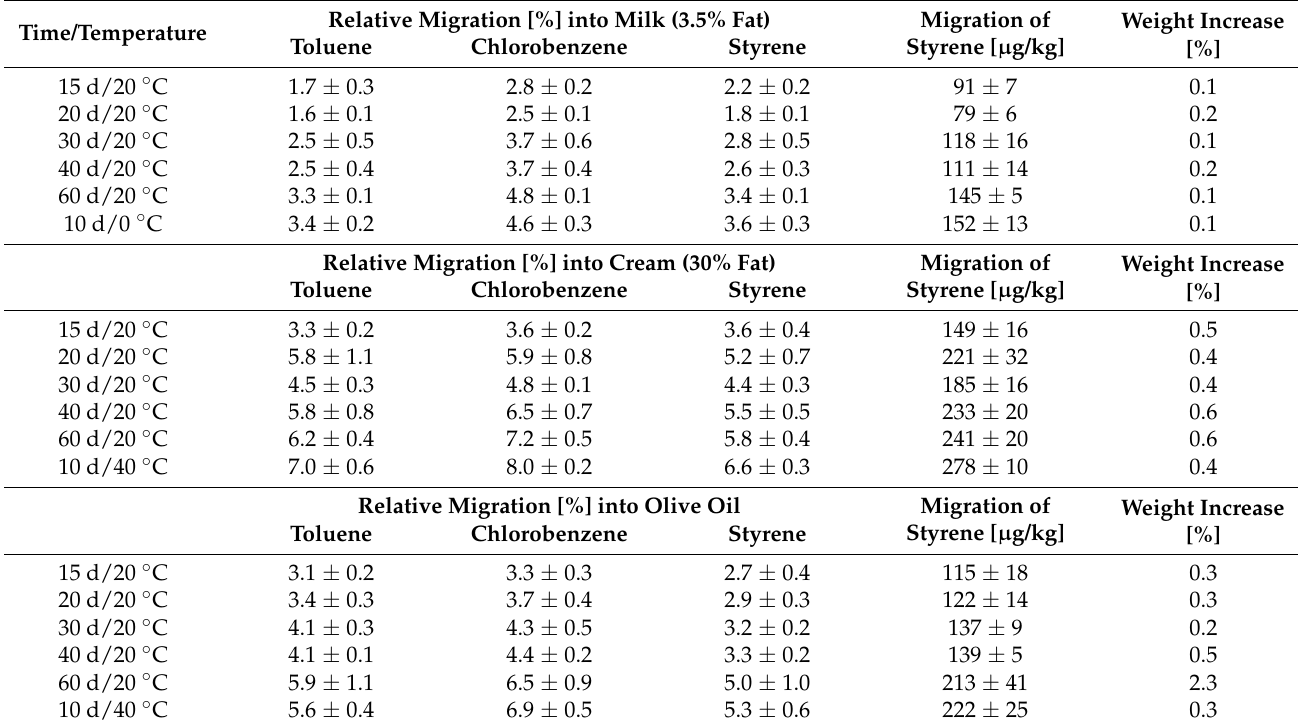
Table 3. Relative migration [%] of volatiles, migrated amount of styrene in real foods and weight increase [%] of the polymer at the tested time/temperature conditions from